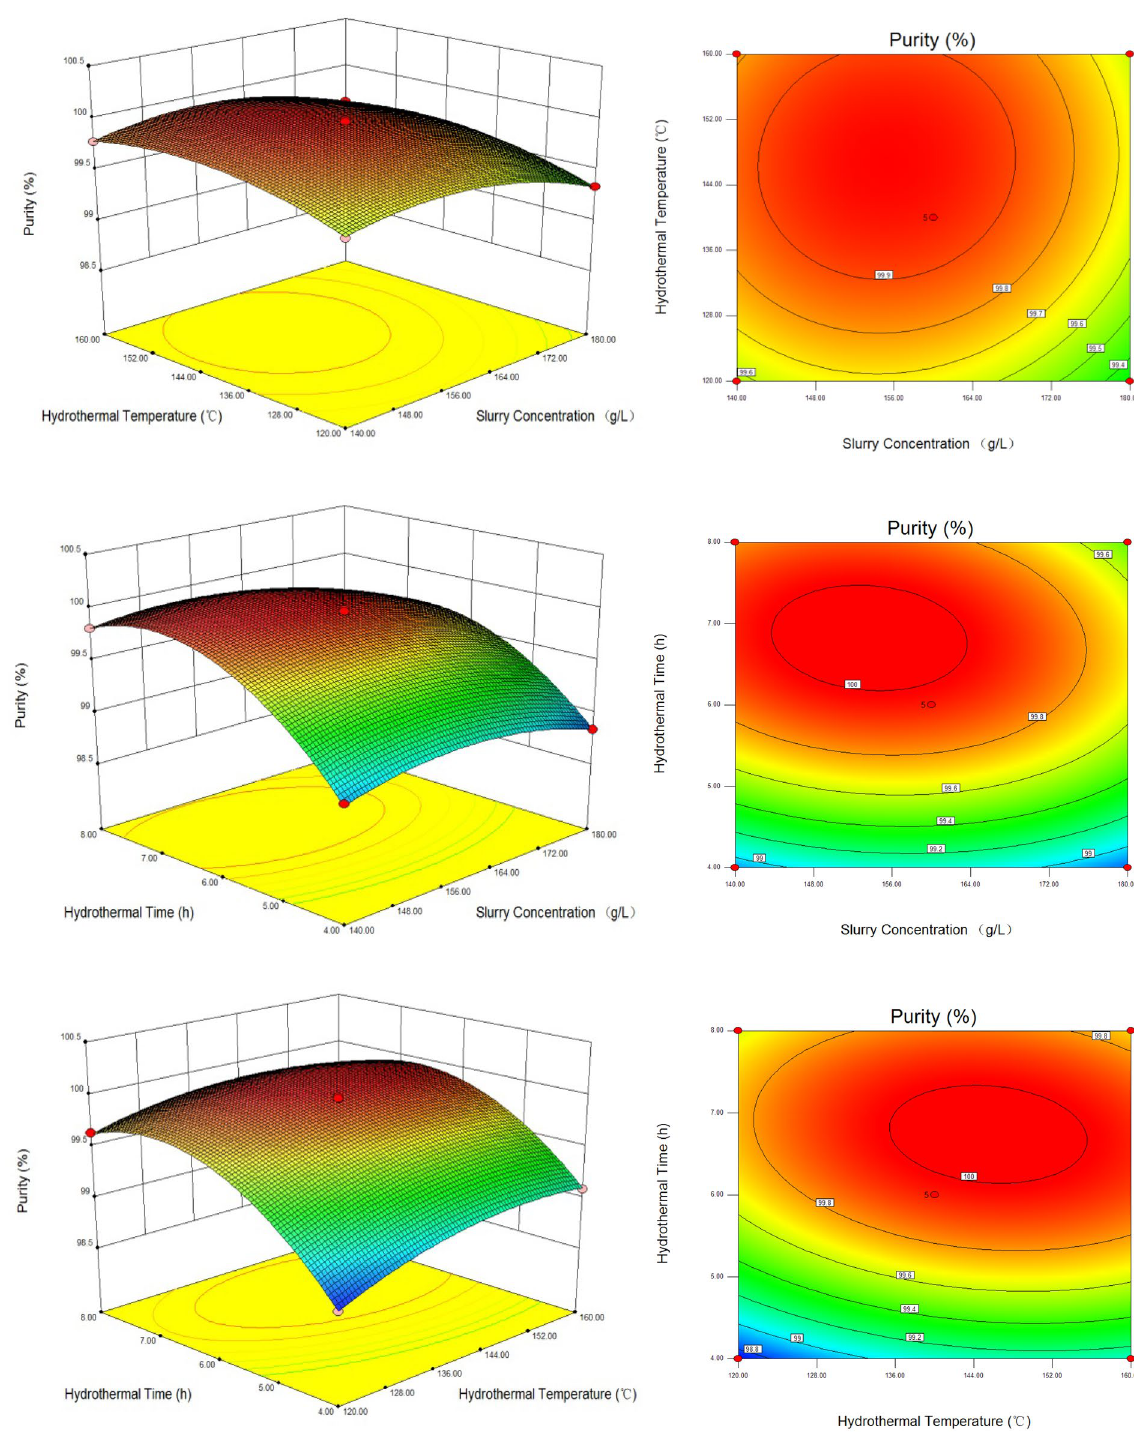
Figure 3. Response surface plots and contour line of effects of interaction between each factor on the purity of